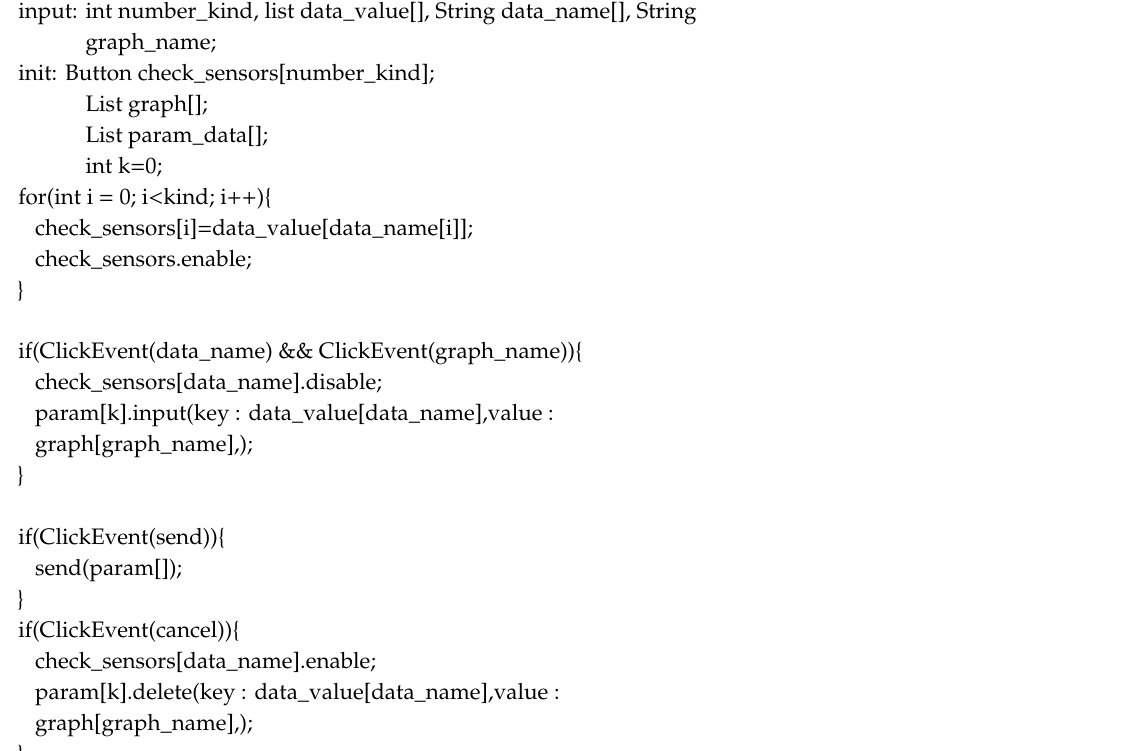
Algorithm 2. Data visualization